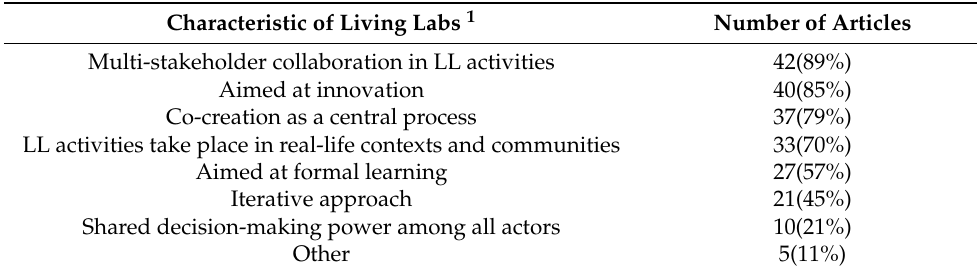
Table 2. Summary of explicit reference to key LL characteristics. Characteristic of Living Labs 1 Number of Articles Multi-stakeholder collaboration in LL